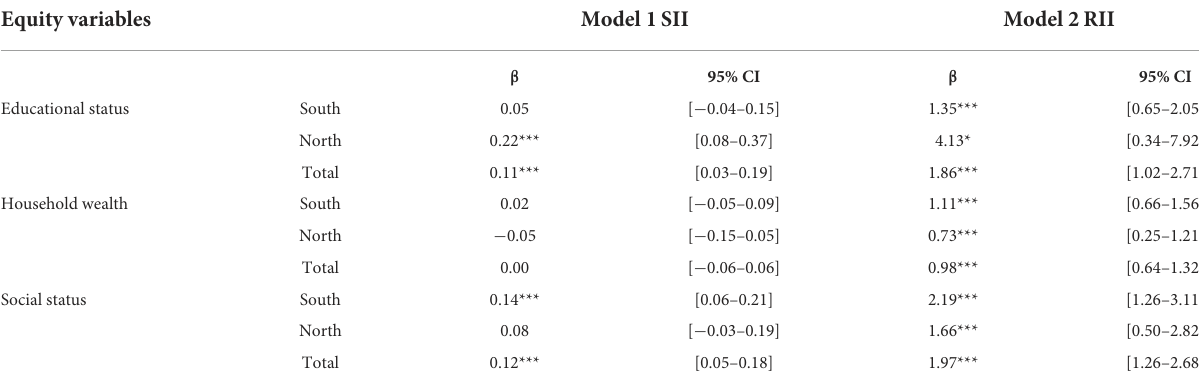
TABLE 4 Measures of inequality in the uptake of modern contraceptives among adolescent girls in selected urban slums in